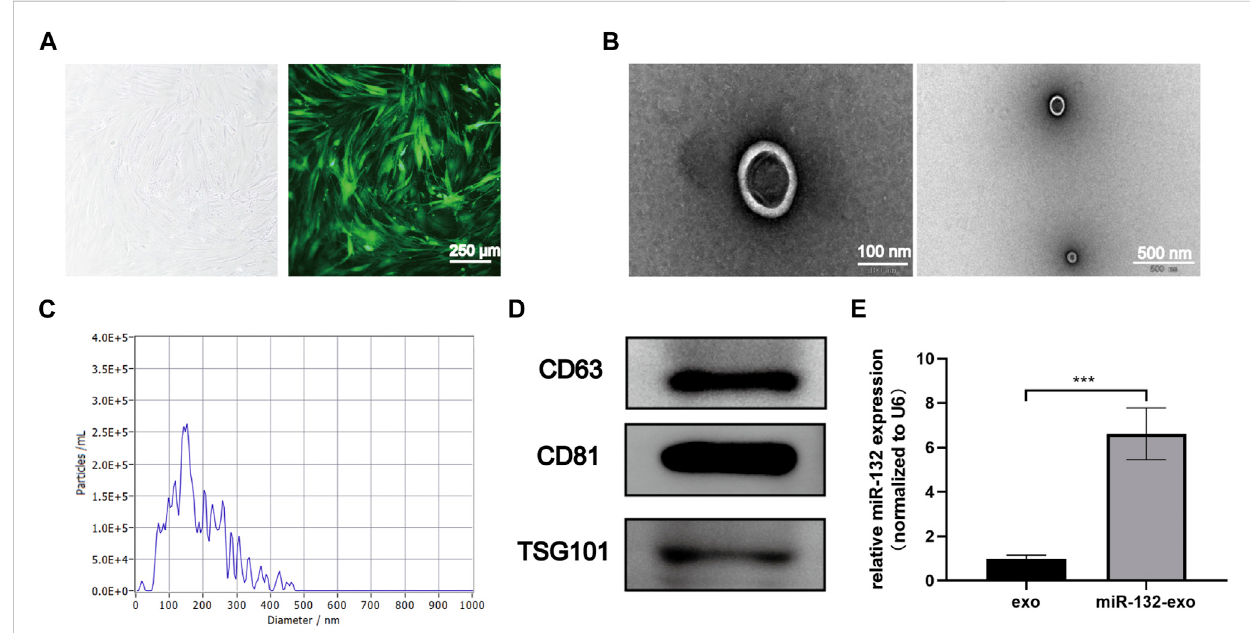
FIGURE 1 Characterization of ADSCs derived exosomes and the transduction ef fi ciency. (A) The typical cobblestone-like morphology of ADSCs (left), and the morphology of ADSCs transfected with lentivirus labled with green fl uorescent protein (GFP) (right); (B) The transmission electron microscopy (TEM) imageofADSCs-Exo(Scale bar=100 nm,500 nm); (C) Sizedistributionofexosomes bynanoparticletrackinganalysis (NTA); (D) Western blotanalysis of exosomes ’ speci fi cmarkersofCD63,CD81,andTSG101; (E) Loadingef fi ciencyoftheLentivirusinADSCsderivedexosomescalculatedbyqRT-PCR; miR-132 were used as a positive control, and expression was normalized to the housekeeping gene U6. * p < 0.05, ** p < 0.01, *** p < 0.001, data are presented as the mean ± SD, n =